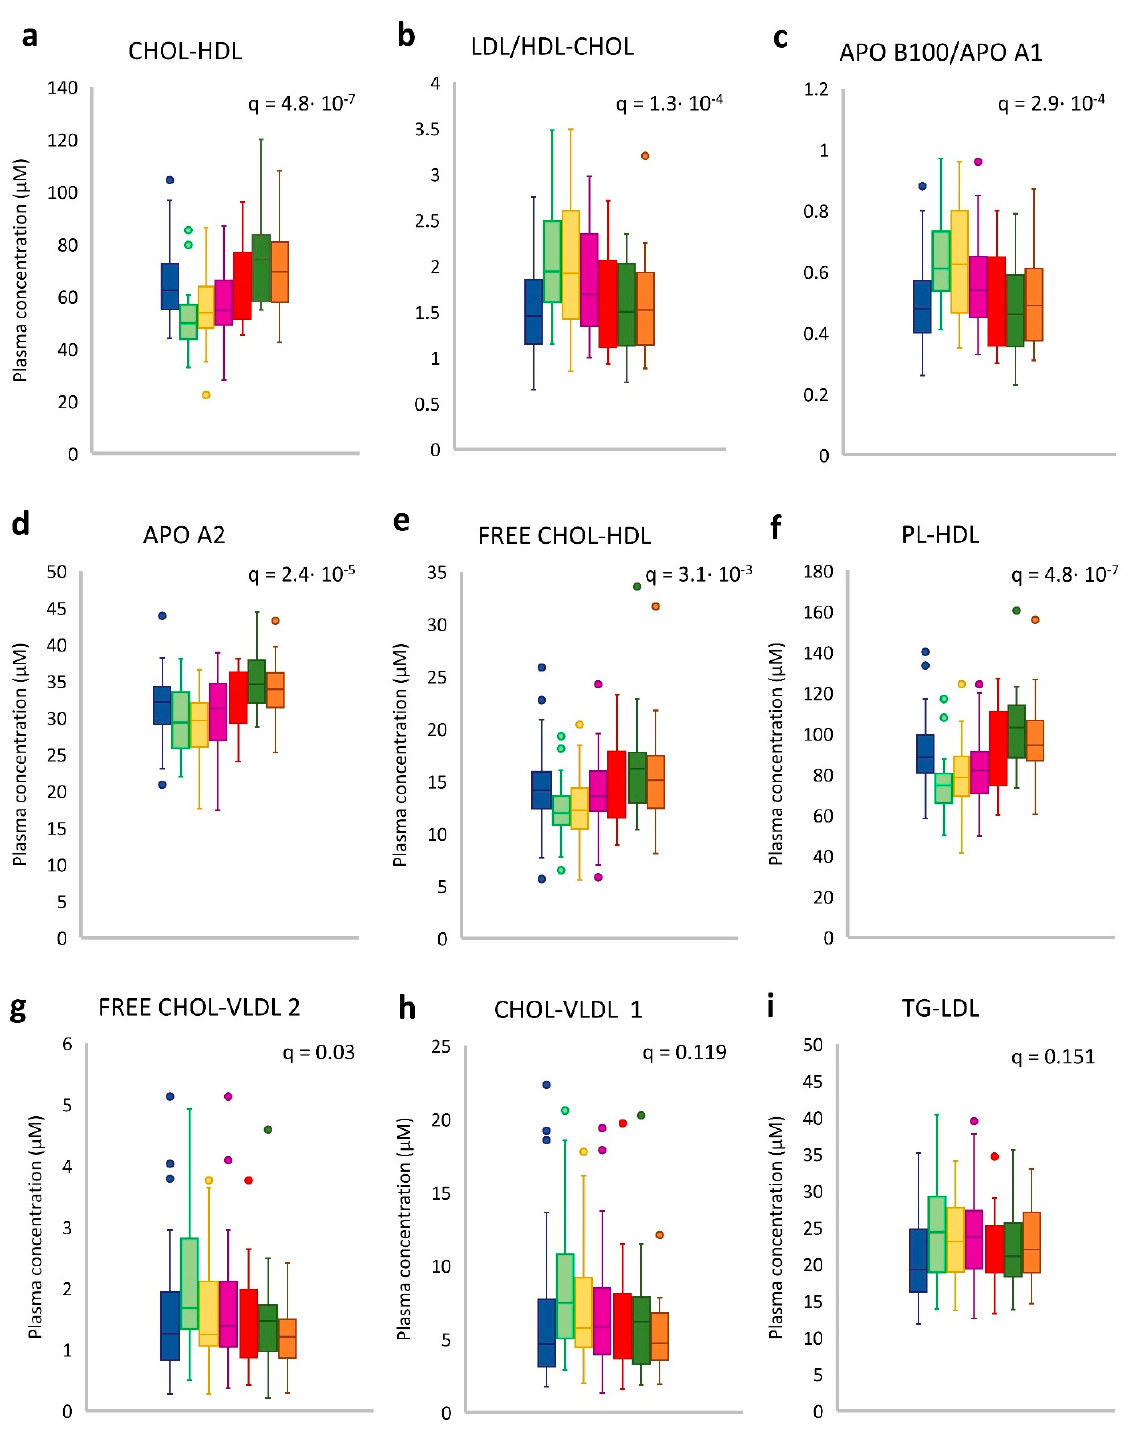
Figure 5. Time-related changes of some representative plasma lipoproteins levels over the treatments and follow-up ( n = 32). Boxes are coloured differently accordingly to the time point: the diagnosis (T1, blue), after three (T2, light green) and six months (T3, yellow) from the NACT starting, two months (T4, violet), and six (T5, red) months after the surgery, in the first-year (T6, dark green) and two-year follow-up (T7, orange). Horizontal lines indicated the median values that separated the lower 25th and the upper 75th quartile; vertical lines denote the highest and lowest whiskers; dots are observations outside the quartiles